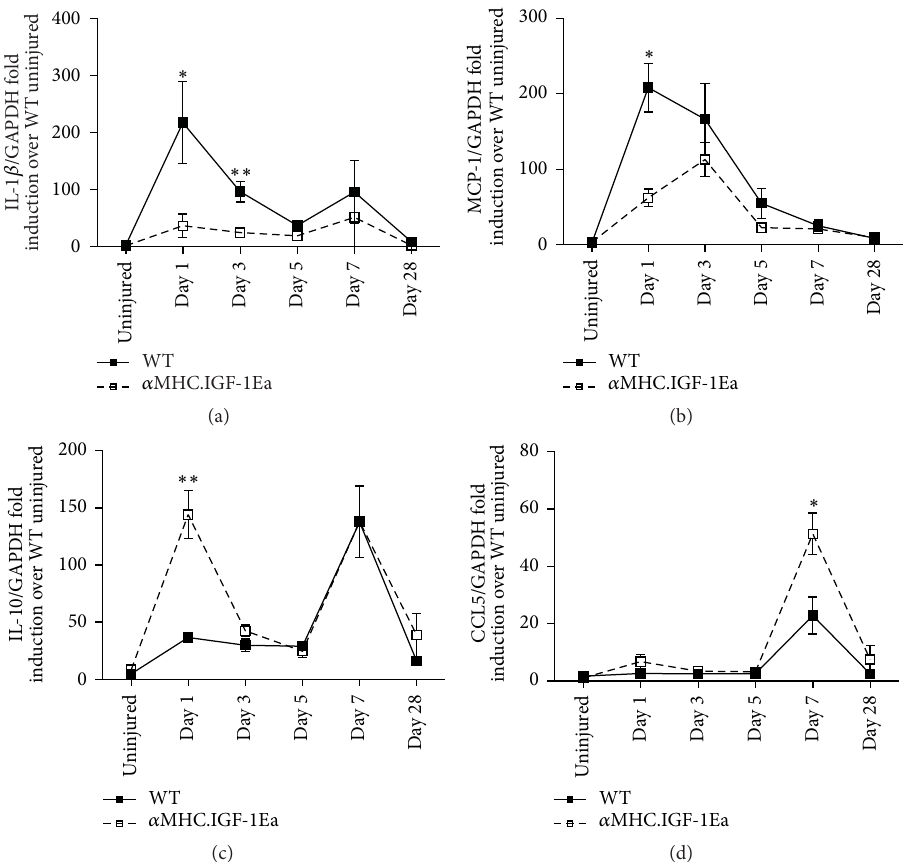
Figure 3: Cytokine dynamics in the infarcted 𝛼 MHC.IGF-1Ea hearts. (a) Interleukin- (IL-) 1 𝛽 , (b) MCP-1, (c) IL-10, (d) CCL5 at several time points after permanent ligation. Solid lines represent WT mice. Dashed lines represent 𝛼 MHC.IGF-1Ea mice. Results are expressed as mean fold induction ± SEM over the values of uninjured hearts. 𝑛 = 3 per group. Two-tailed Student’s t -test was performed to compare WT versus 𝛼 MHC.IGF-1Ea at selected time points after MI. ∗ 𝑃 < 0.05 , ∗∗ 𝑃 < 0.005